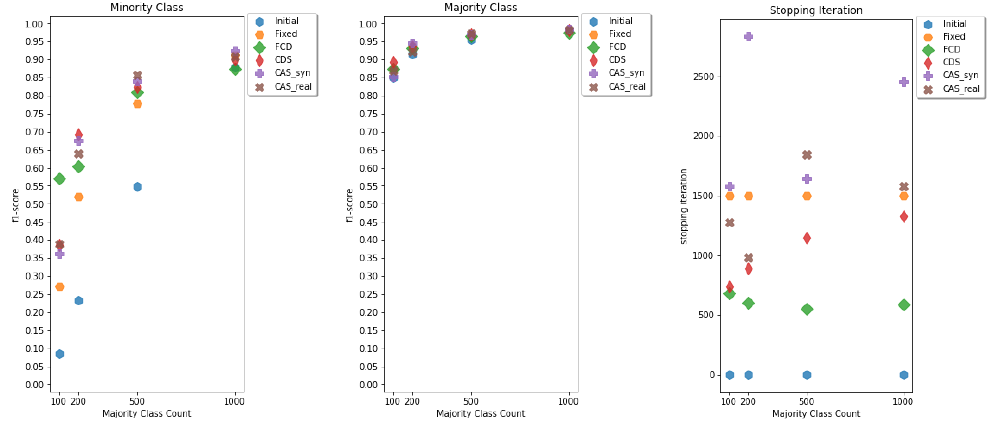
Figure 15. Average F1 results of cira-based datasets by majority class count for minority ( left ) and majority ( center ) classes, and average number of iterations until the training is stopped ( right